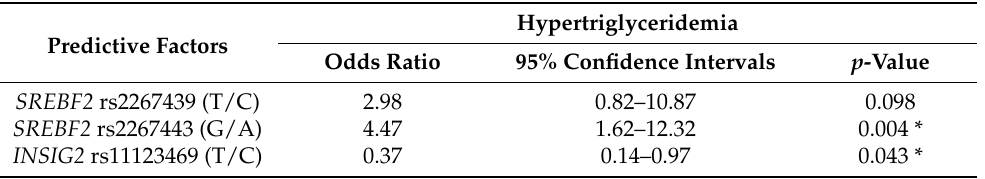
Table 5. Multivariate logistic regression analysis of the predictive factors for risperidone-induced hypertriglyceridemia in patients with psychotic disorders ( n = 113). Hypertriglyceridemia Predictive Factors Odds Ratio 95% Confidence Intervals p -Value SREBF2 rs2267439 (T/C) 2.98 0.82–10.87